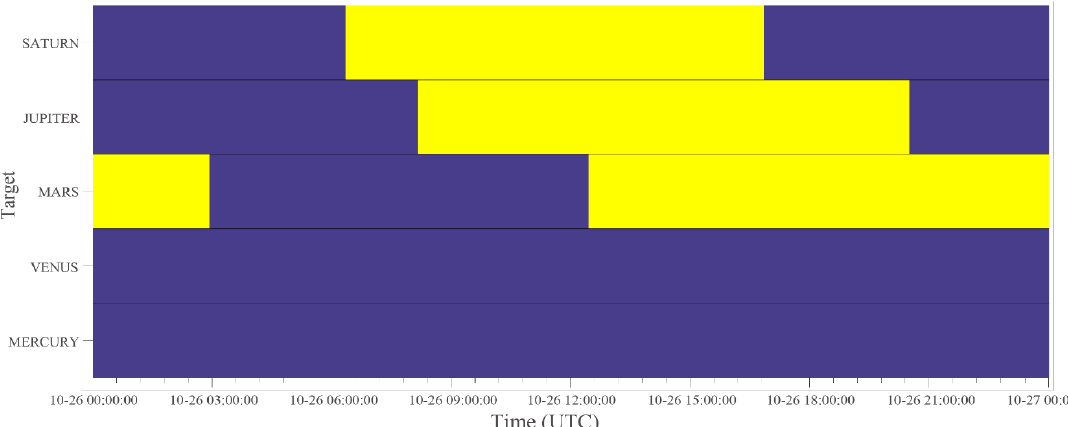
Figure 9. Observation windows for the PAST on 26 October 2022. Information is shown in the same format as in Figure 4.